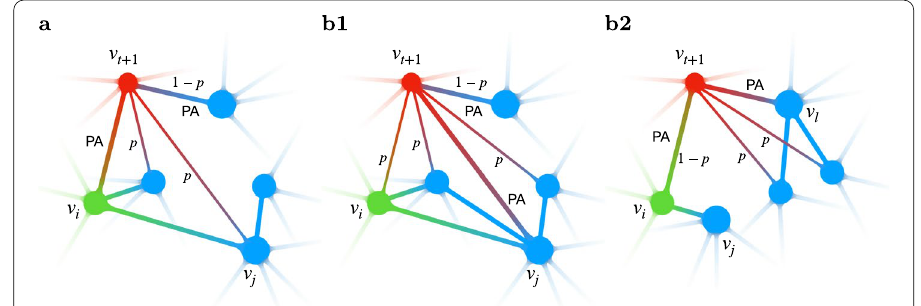
Fig. 11 The cases in which the degree of node v i may change at iteration t + 1 of the triadic closure model. PA means that the link is attached using the preferential attachment (PA)